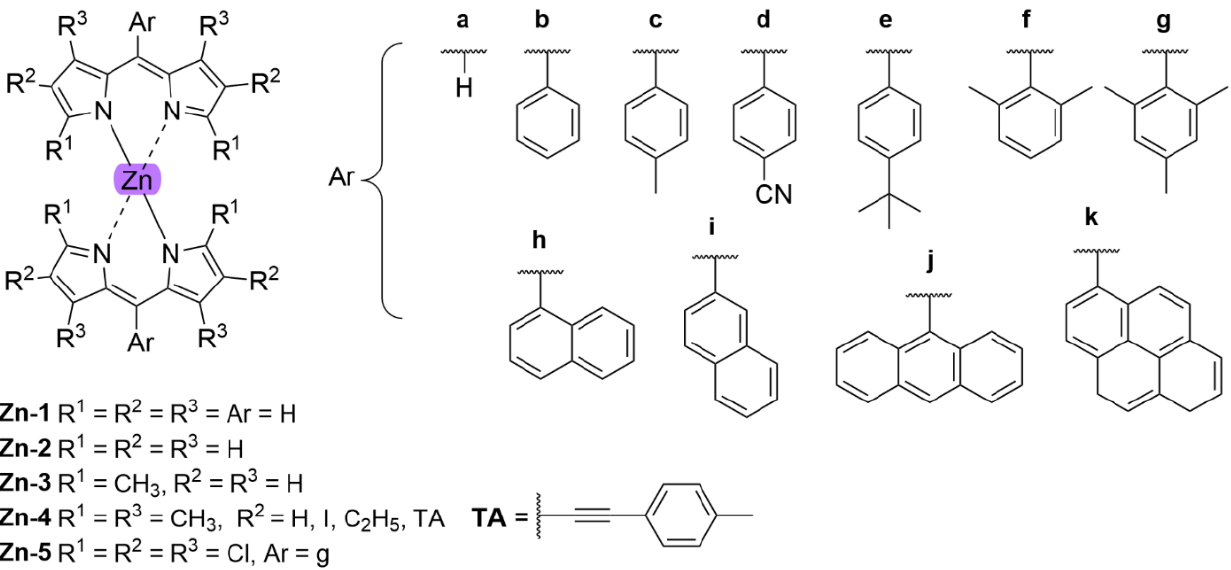
Figure 16. Chemical structures of homoleptic bis(dipyrrinato)Zn(II) complexes (b = Ph, c = C 6 H 4 , d = PhCN, g = Mes). d = PhCN, g =